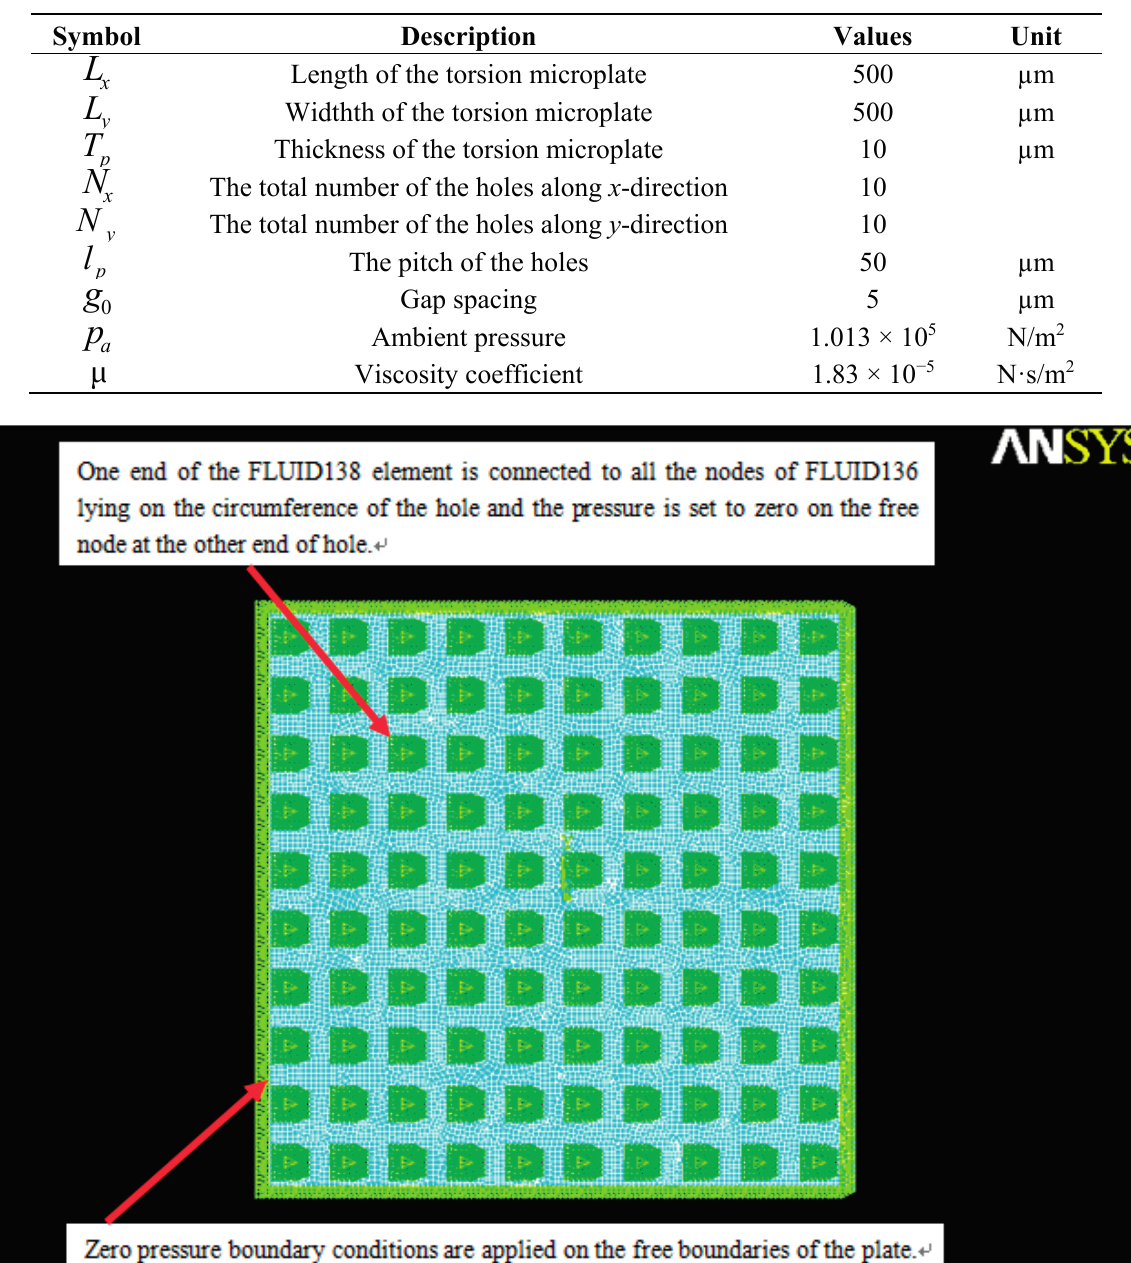
Table 3. Dimensions and parameters for the type I microplate.